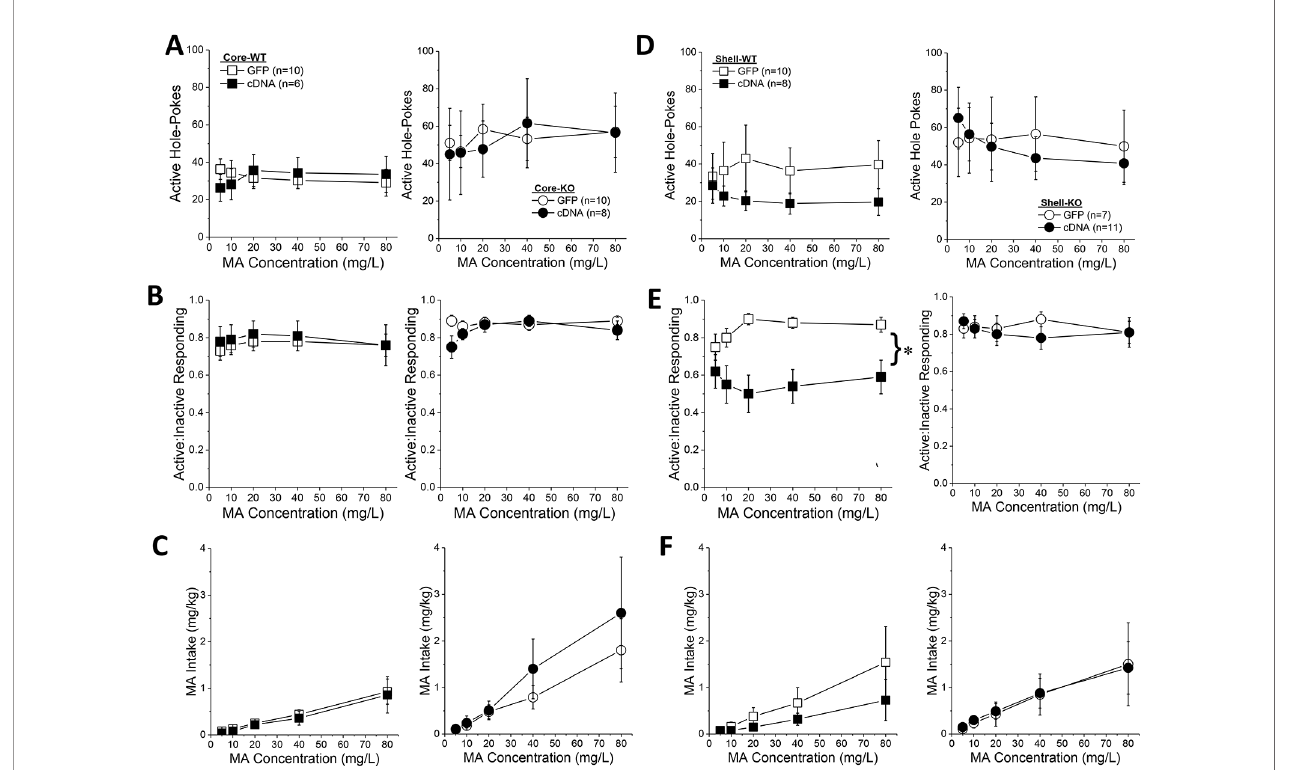
FIGURE 7 | Homer2b overexpression in the nucleus accumbens (NAC) shell blunts methamphetamine (MA) reinforcement only in wild-type (WT) mice. When compared to WT (left) and Homer2 knockout (KO) (right) mice infused with green fl uorescent protein (GFP), cDNA infusion into the NAC core did not alter the dose- response functions for: (A) active hole responding, (B) response allocation or (C) MA intake. (D) cDNA infusion into the NAC shell caused a declining dose-response function for active hole-responding in both WT and KO mice, (E) lowered the dose-response function for response allocation in the active hole in WT mice, but (F) did not signi fi cantly alter the dose-response function for MA intake. The data represent the means ± SEMs of the number of mice indicated in Panel A (NAC core) and Panel D (NAC shell). *p < 0.05, main AAV effect. Main Genotype effects are not indicated for clarity but are described in the detected for this measure (Genotype X AAV ANOVA, p ’ s > infusion into the NAC shell altered the time taken to extinguish responding ( Figure 7E ) [AAV X Dose: F(4,120) = 2.89, p = 0.03] responding in the active hole ( Figure 8B ; Genotype X AAV ANOVA, p ’ s > 0.31). A comparison of active hole responding during the last day of extinction with that elicited by presentation of the MA-associated cue or a priming injection of 1 or 2 mg/kg MA indicated greater responding, overall, in Homer2 KO versus WT mice, irrespective of the AAV infused into the NAC core ( Figure 8C ) [Test effect: F(3,81) = 6.31, p = 0.001; Genotype effect: F(1,27) = 5,26, p = 0.03; no AAV effect and no interactions,